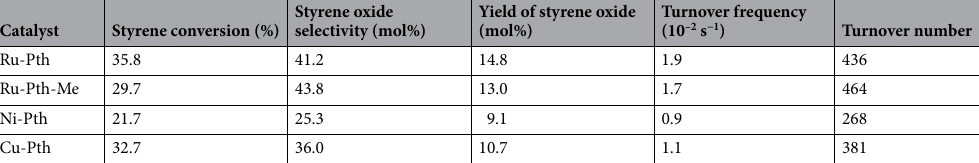
Table 1. Selective photocatalytic oxidation of styrene-to-styrene oxide over metal pyrithione complexes. Reaction conditions: Catalyst to styrene ratio of (1:100); styrene : H 2 O 2 (1:1); time: 3 h; solvent: acetonitrile; temperature: 60 °C, Turnover frequency (TOF) = moles of styrene converted/(moles of metal × time); Turnover number (TON) = moles of styrene oxide formed/moles of metal.